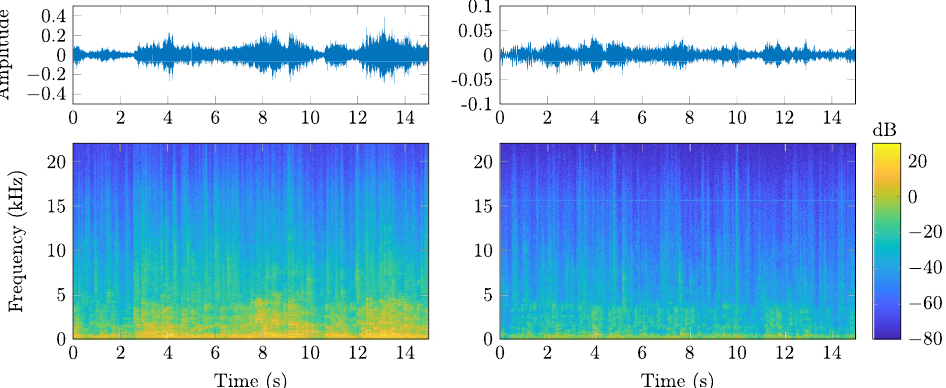
Fig. 11 Waveform and corresponding spectrogram for a 15 s sample of the cocktail party noise. (Left) Signal CP2 for XM2 in the SAL. (Right) Signal CP5 for XM2 in the